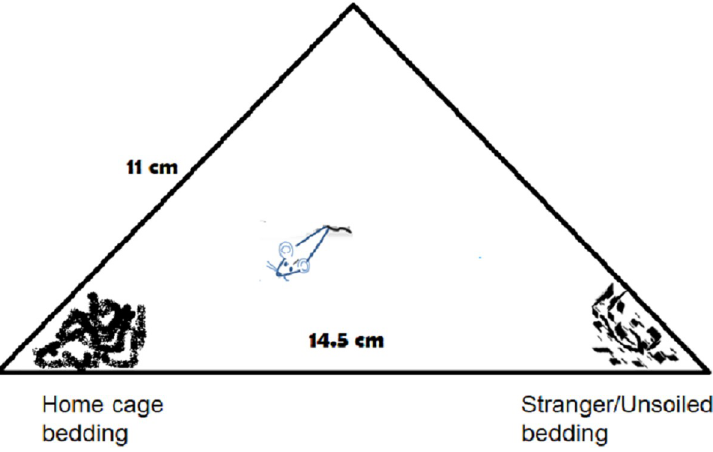
Fig 1. Schematic drawing of the apparatus used to measure nest odor preference in mouse pups in Experiment 3. Experiment 3: Reflex development and social attachment in male and female PON1 -/-